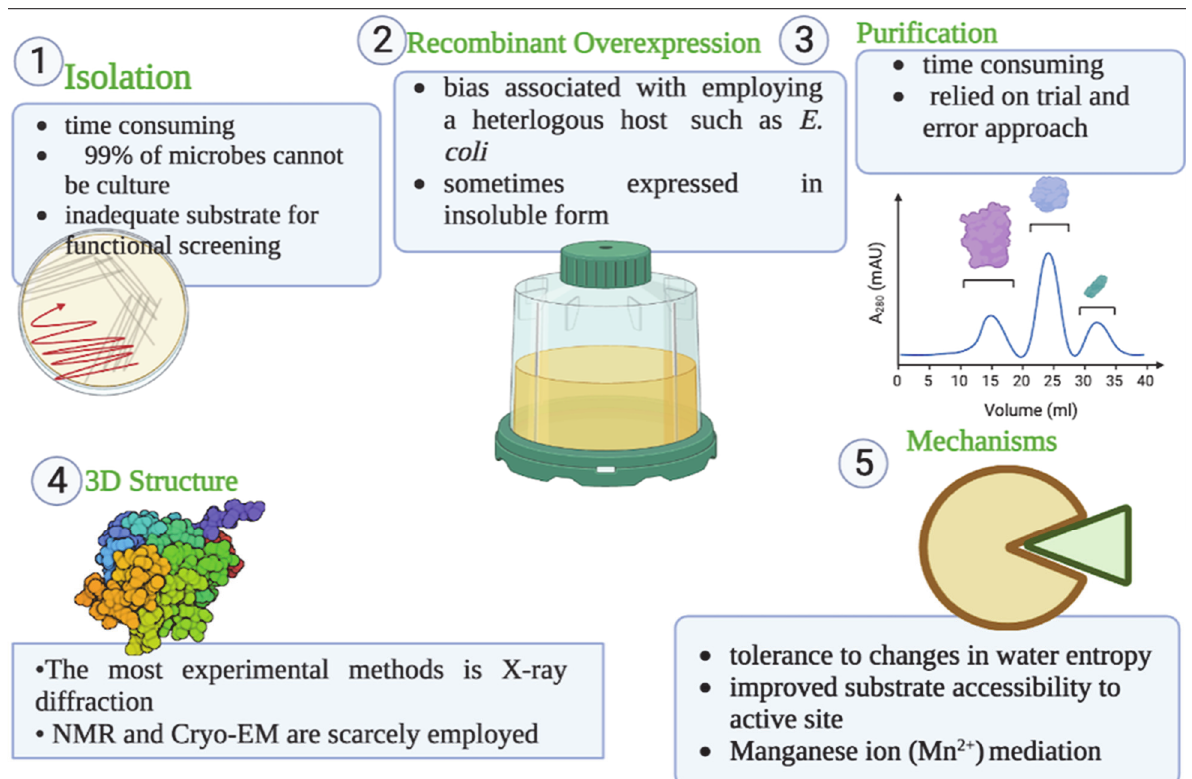
Figure 1. Summary of various sections of this review (Created with BioRender.com).